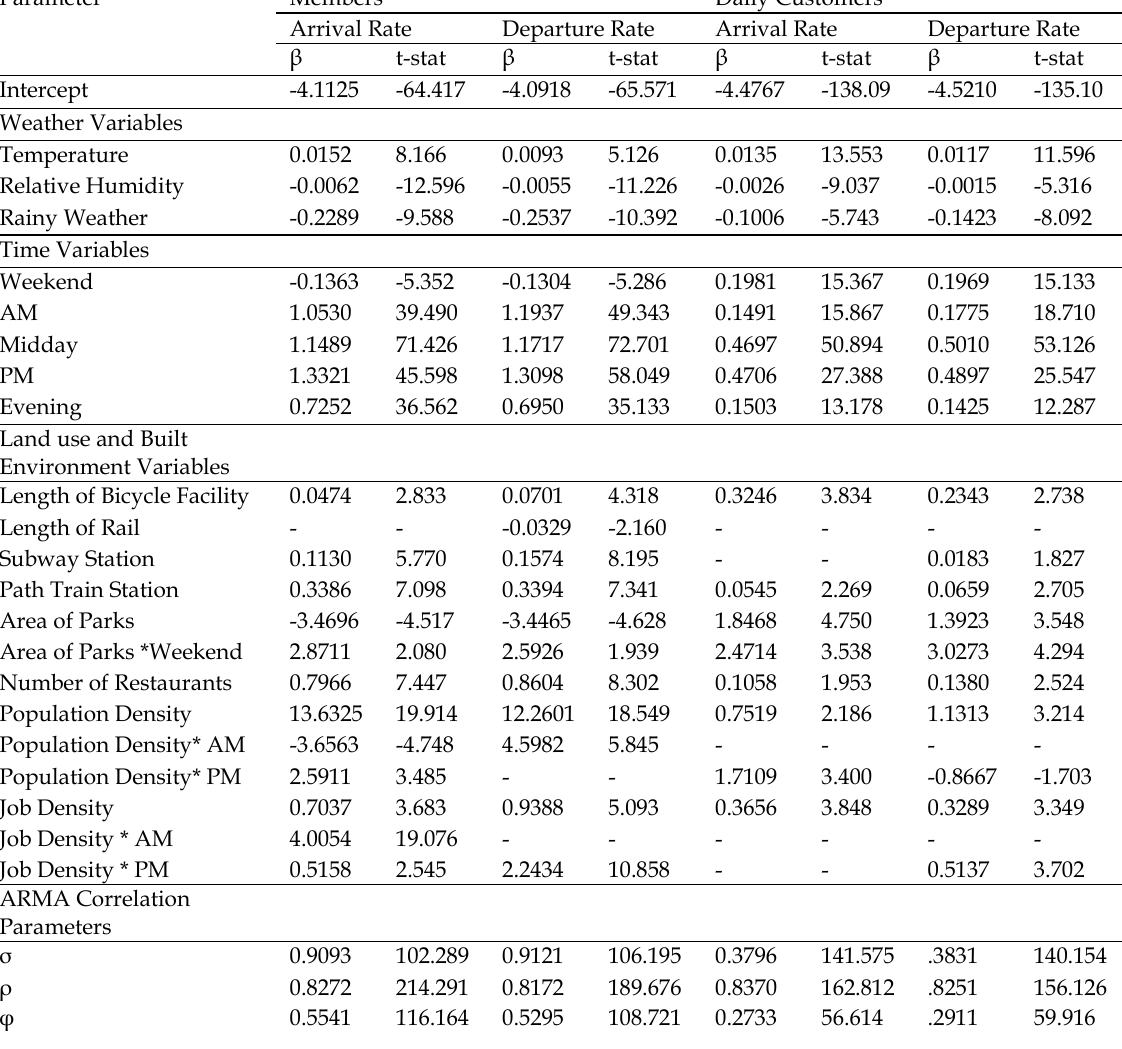
Table 2. Usage Models Estimation